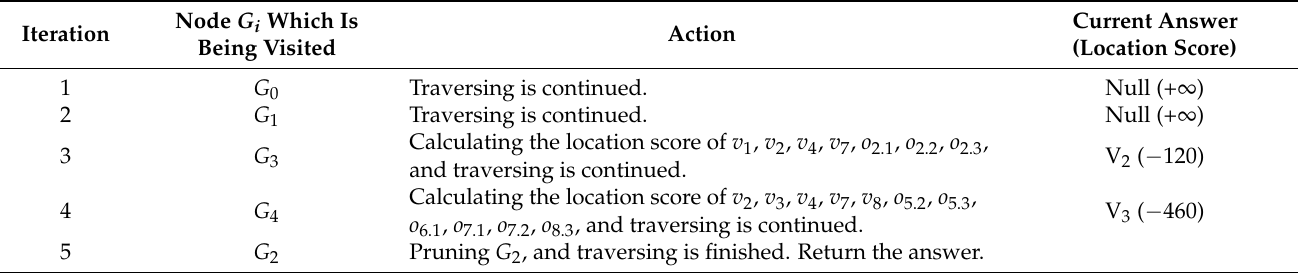
Table A12. Procedure of the G + -tree traversal.